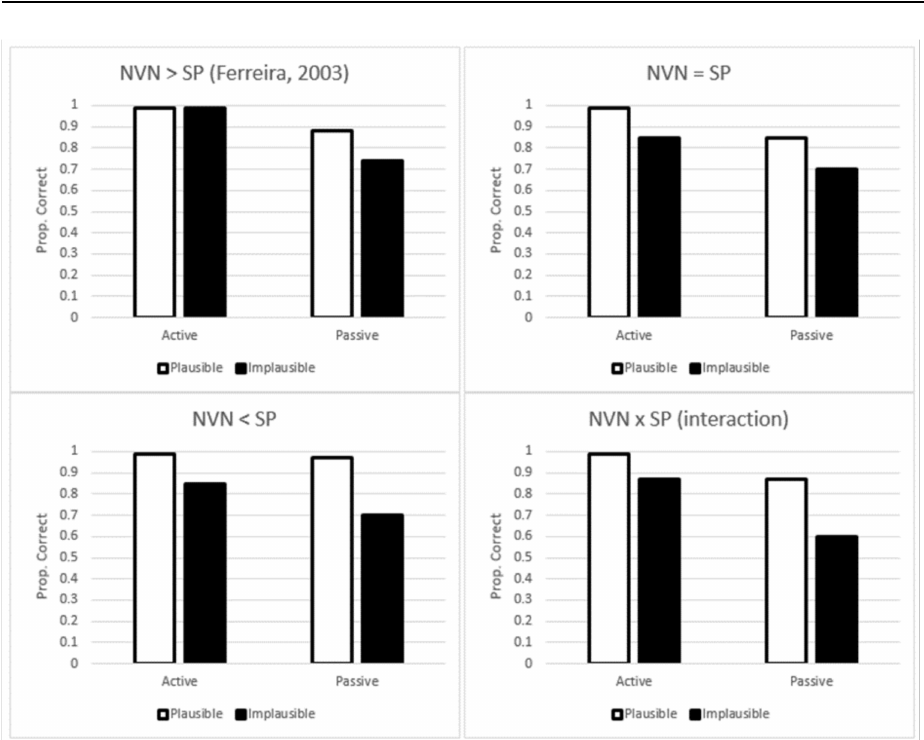
Figure 1. Predicted comprehension results based on the impact of noun-verb-noun (NVN) and semantic plausibility (SP)